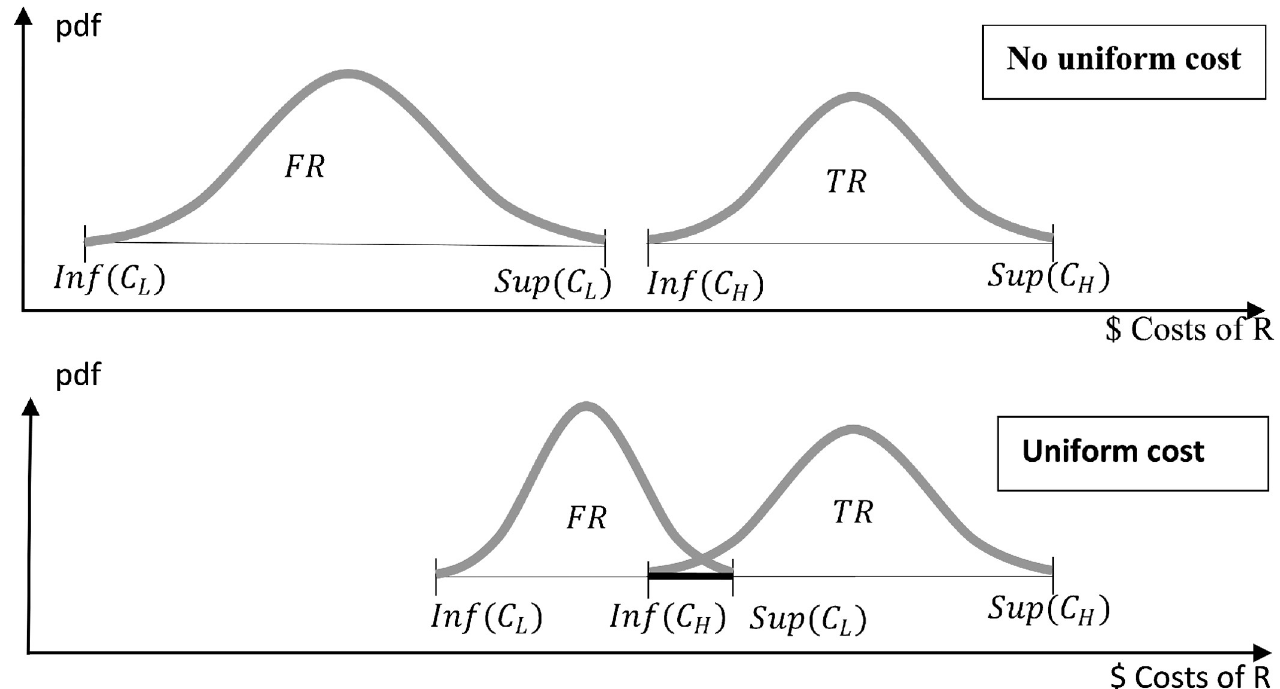
Fig 4. Unifying reporting standards and its impact on the cost of reporting money laundering relative to noise for reporting entities.